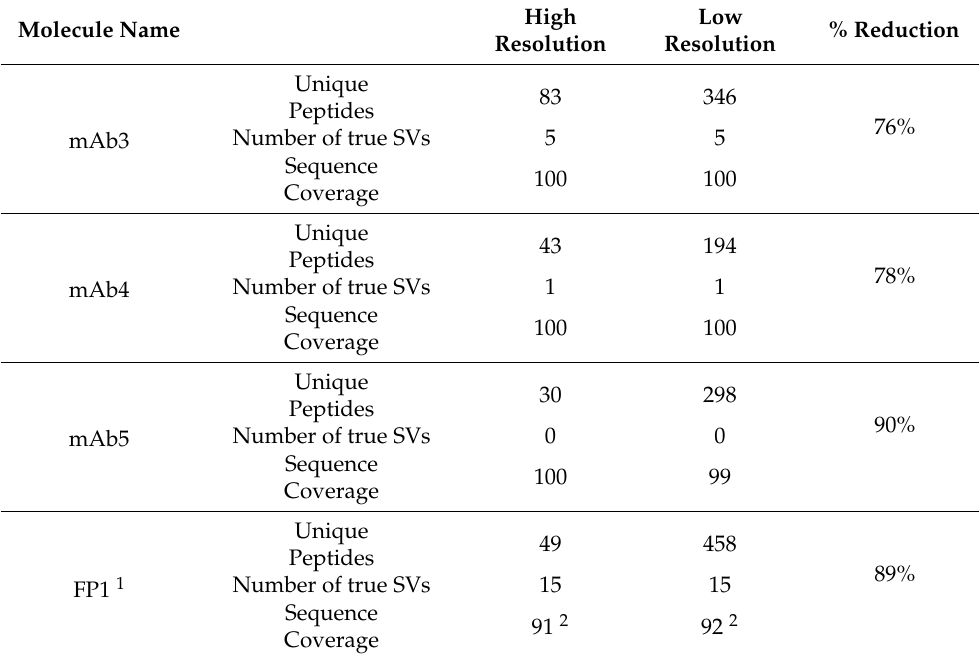
Table 2. High vs. low-resolution SVA unique peptides, detected SVs, and sequence coverage